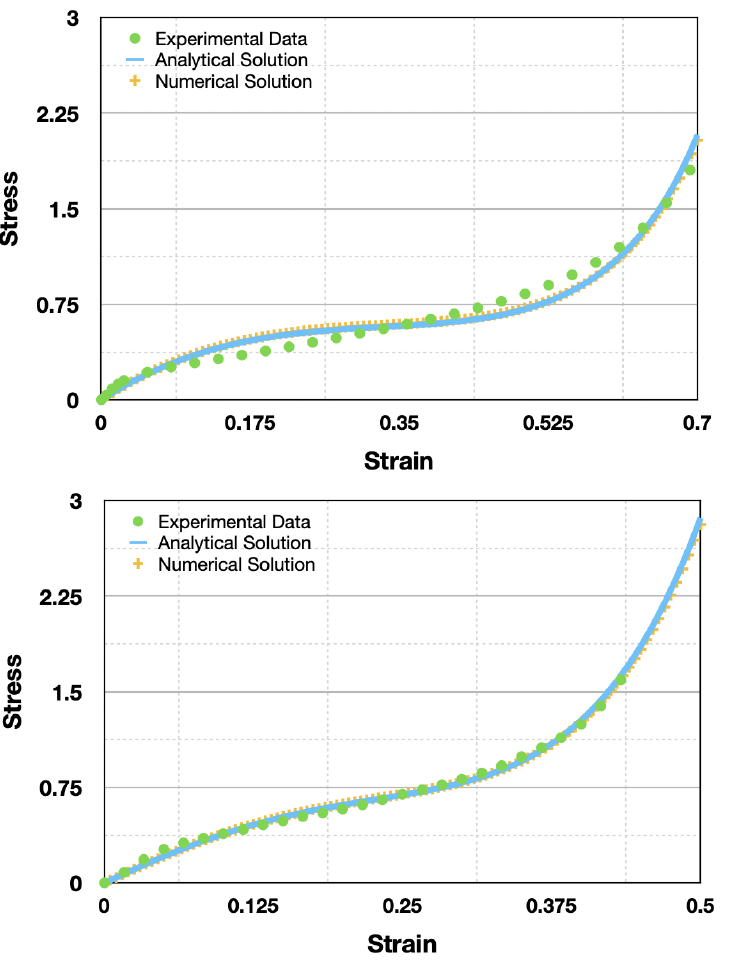
Figure 7. Comparison between numerical, analytical and experimental solutions for uniaxial and equibiaxial compression tests,